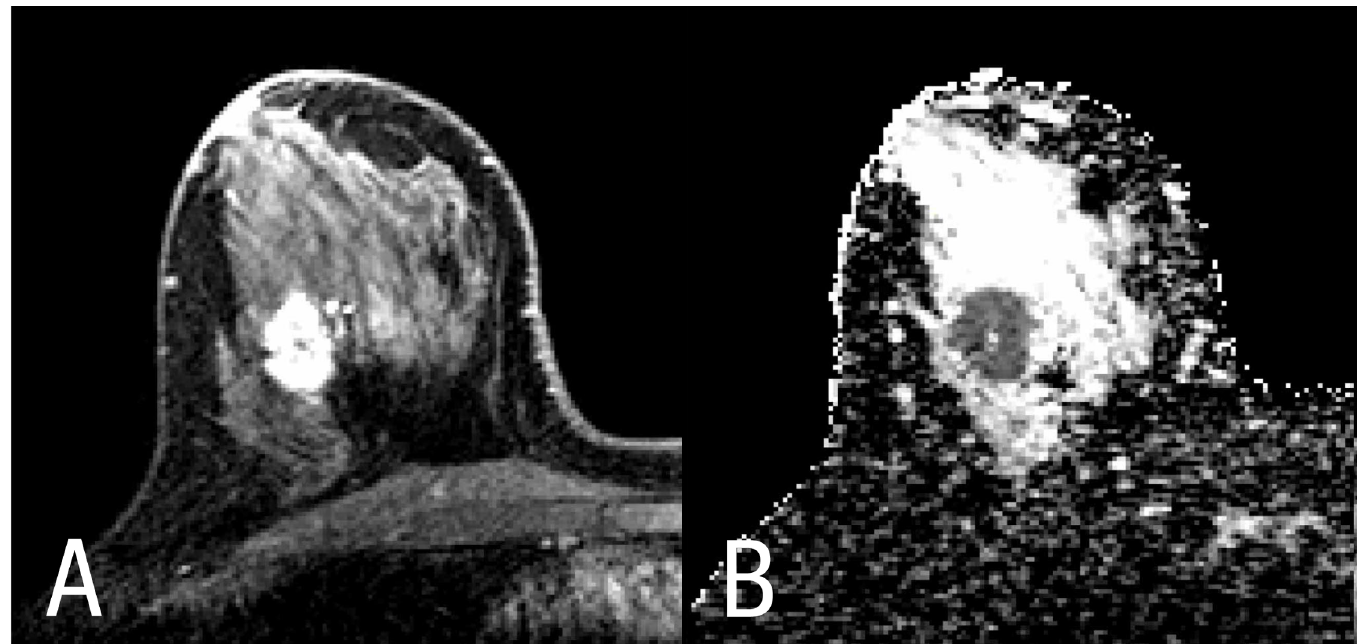
Fig 1. Lesion differentiation in (A) dynamic contrast-enhanced magnetic resonance imaging (MRI, left) and in (B) diffusion-weighted imaging (DWI, right) of the right breast of a 41-year-old